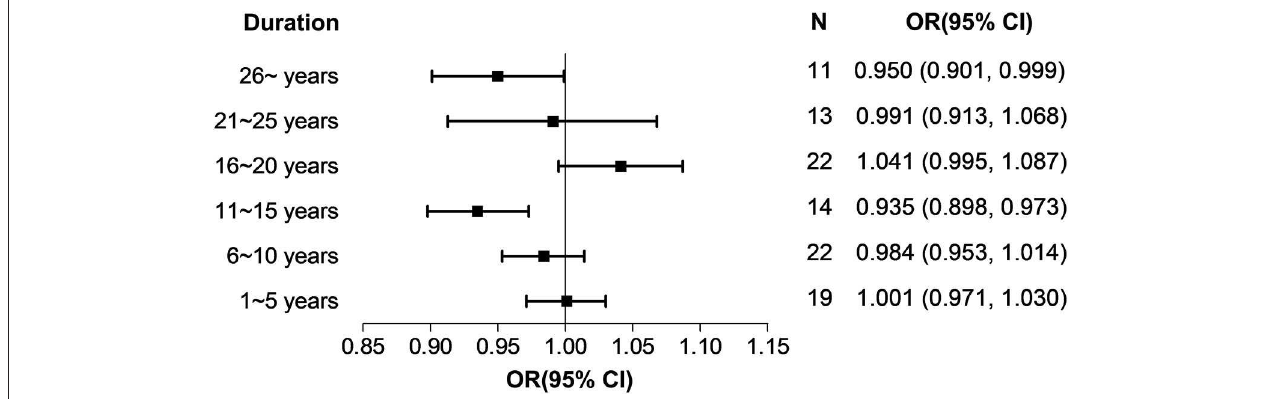
FIGURE 4 | Analysis on classifications of night-shift work duration.